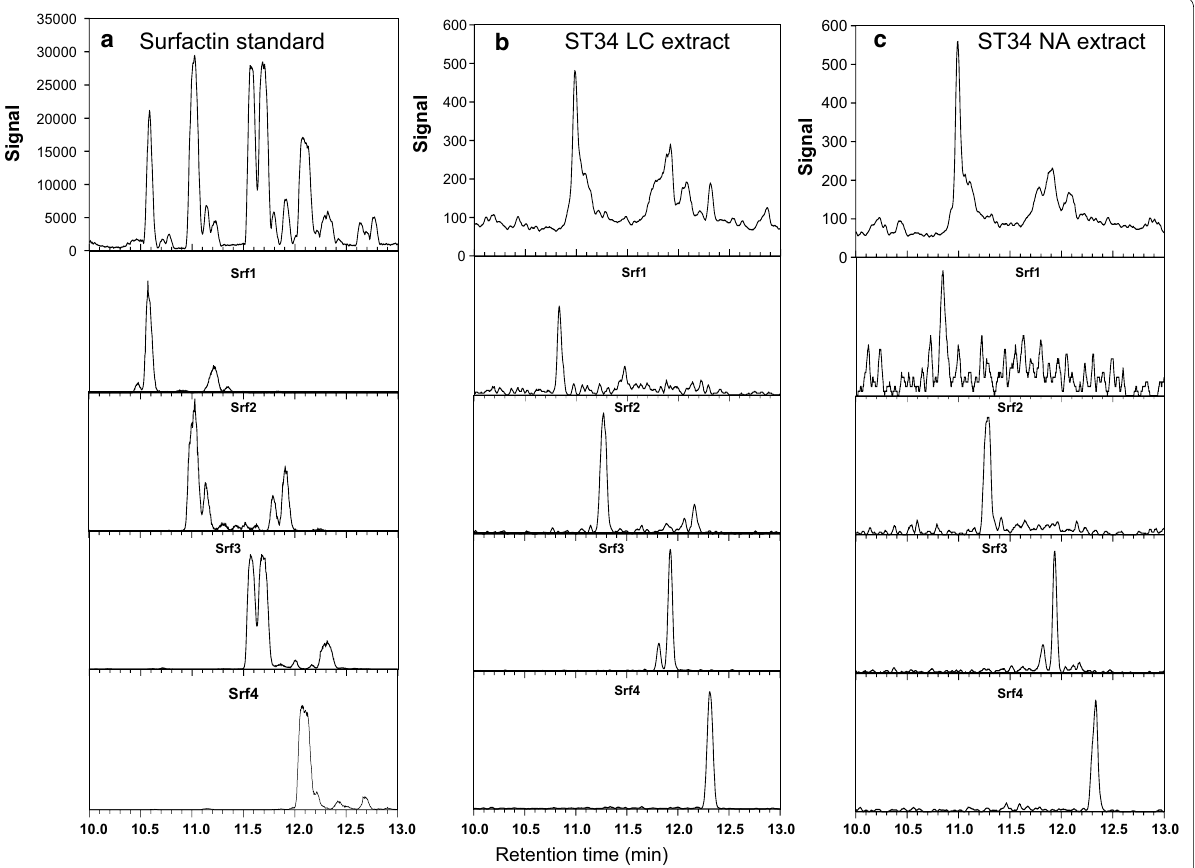
Fig. 2 UPLC–MS profiles of surfactin standard ( a ), ST34 glycerol-MSM liquid culture (ST34LC) extract ( b ) and ST34 nutrient agar surface culture (ST34NA) ( c ) showing the five major surfactin groups. The top row profiles show the signal of positive molecular ions detected between 10 and 13 min. Note the difference in Y axis which are a direct indication of amounts. The profiles below each top row spectrum show the extracted spectra of the five surfactin groups with Srf1 m/z 994.6, Srf2 m/z 1008.7; Srf3 m/z 1022.7, Srf4 m/z 1035.7 and Srf5 m/z = = = = =